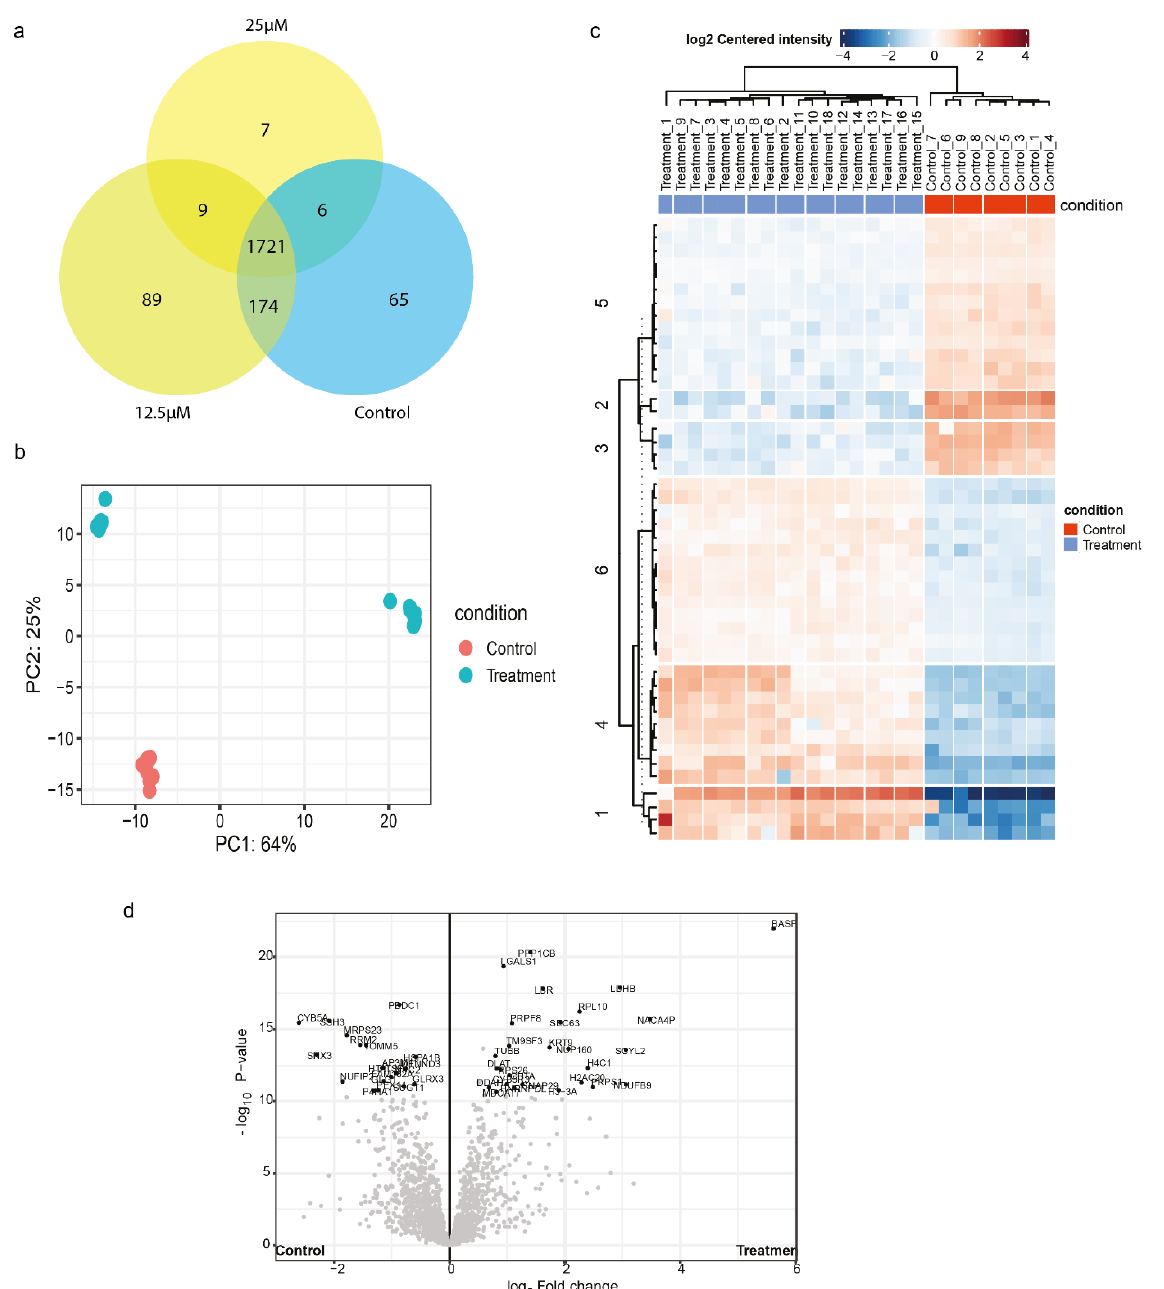
Figure 3. Proteomics analysis upon Galangin treatment in KKU-213 cells. ( a ) Venn Diagram of uniquely identified peptides in each condition. ( b ) Principle-component analysis of control and Galangin treated samples. ( c ) Heatmap of differentially expressed proteins between treatment and control with the significance criteria of proteomics fold change at log2 (1.5) and p < 0.05. ( d ) Volcano plot depicting the differentially expressed proteins (DEP) between control and treatment samples.